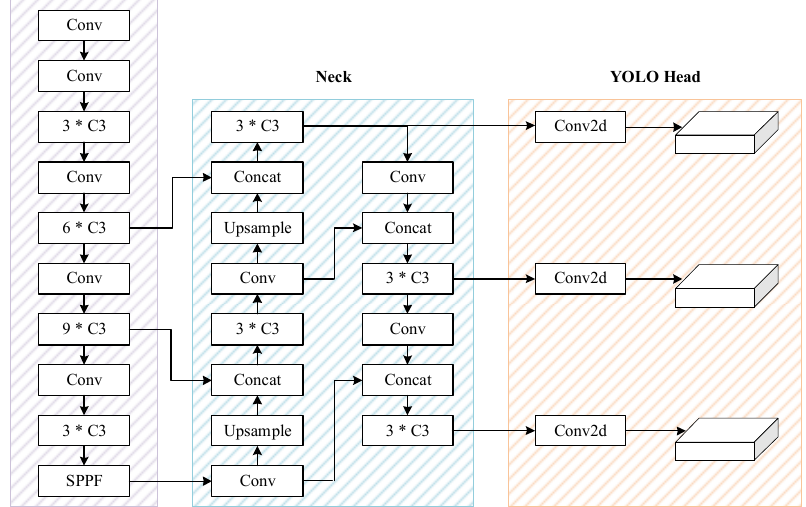
Figure 1. The architecture of YOLOv5 v6.1.